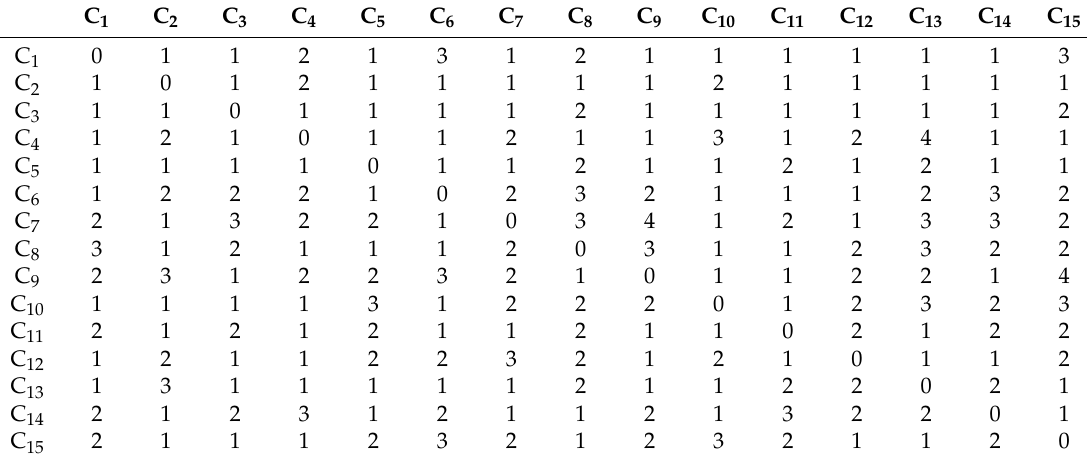
Table 2. The averaged direct-relation matrix for criteria.